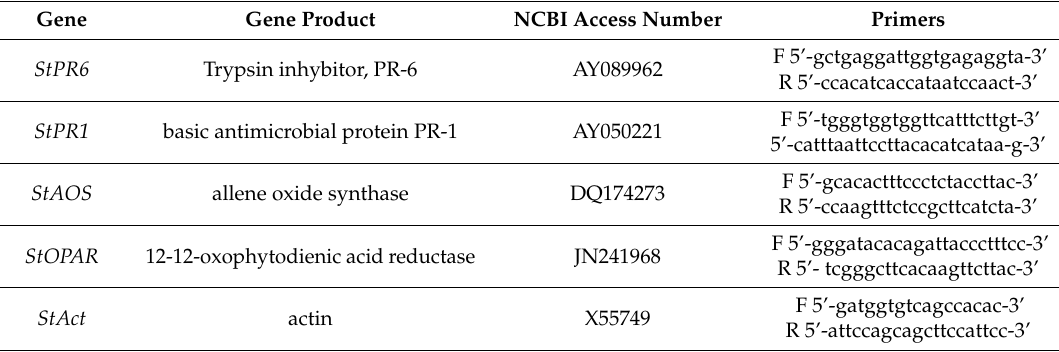
Table 3. Primers used for quantitative PCR.